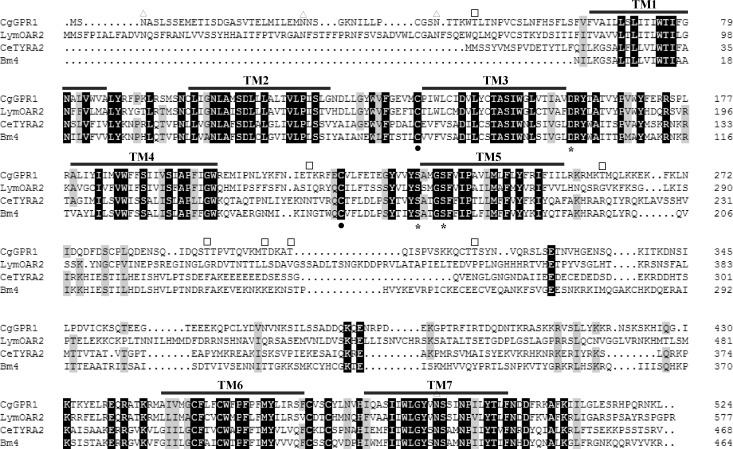
Multiple sequence alignment of CgGPR1 and orthologous receptors.The alignment was performed by ClustalX. The predicted seven transmembrane regions (TM1-TM7) are overlined. Identical and similar amino acids are shaded in black and gray, respectively. Potential N-glycosylation sites and phosphorylation sites for protein kinase C are indicated by triangles and squares, respectively. Amino acid residues that are implicated in agonist binding are labeled by asterisks. Conserved Cys residues in the first and second extracellular loops are indicated by filled circles.